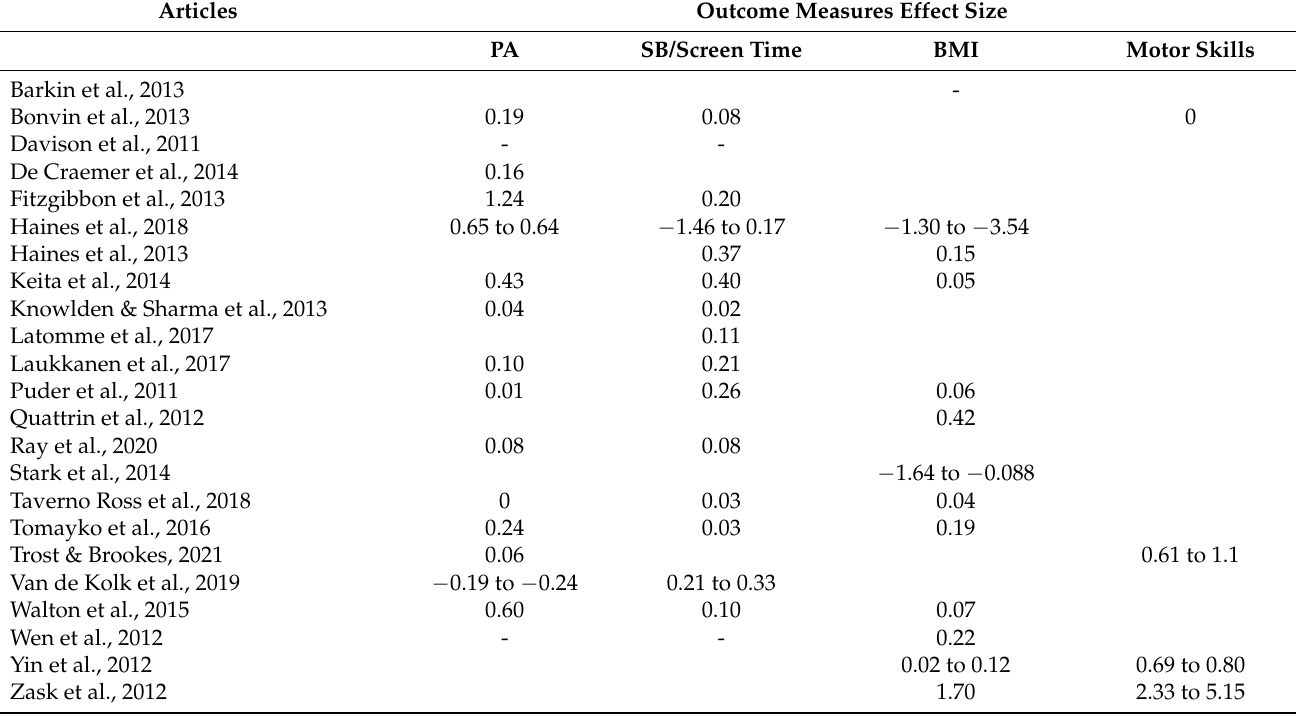
Table 2. Effect sizes of measured outcomes (n =